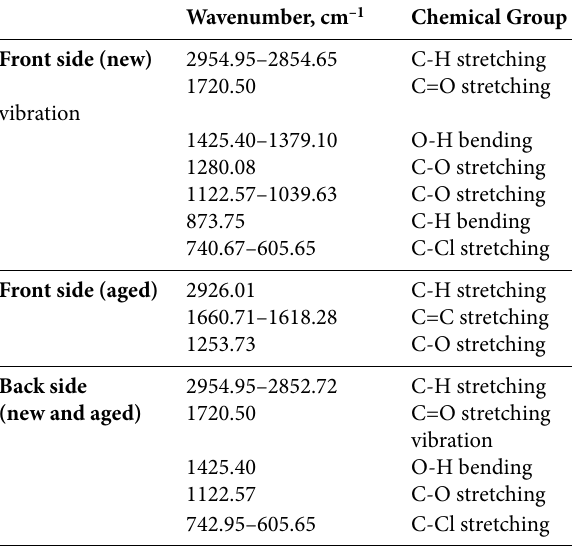
Table 7: Main FTIR bands for the front and back sides of plasticized PVC membranes.